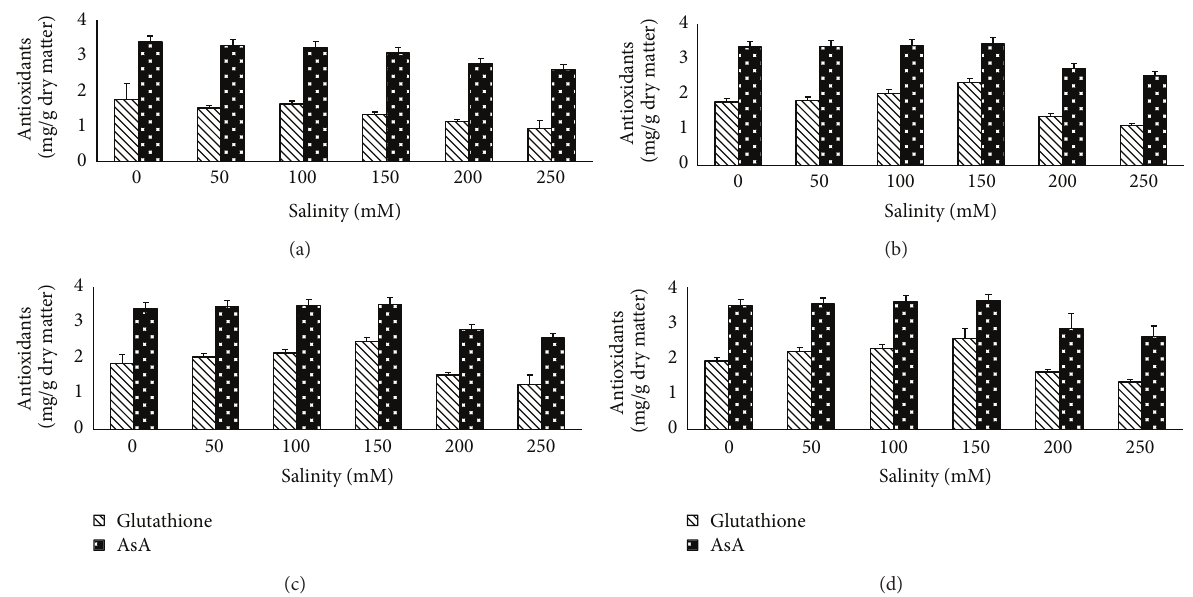
Figure 5: Effect of NaCl on glutathione and ascorbate of T. aestivum grains presoaked in different concentrations of Ulva lactuca : (a) control, (b) algal extract 1%, (c) algal extract 5%, and (d) algal extract 10%. Data are the mean of three replicates and error bars represent the standard errors of the